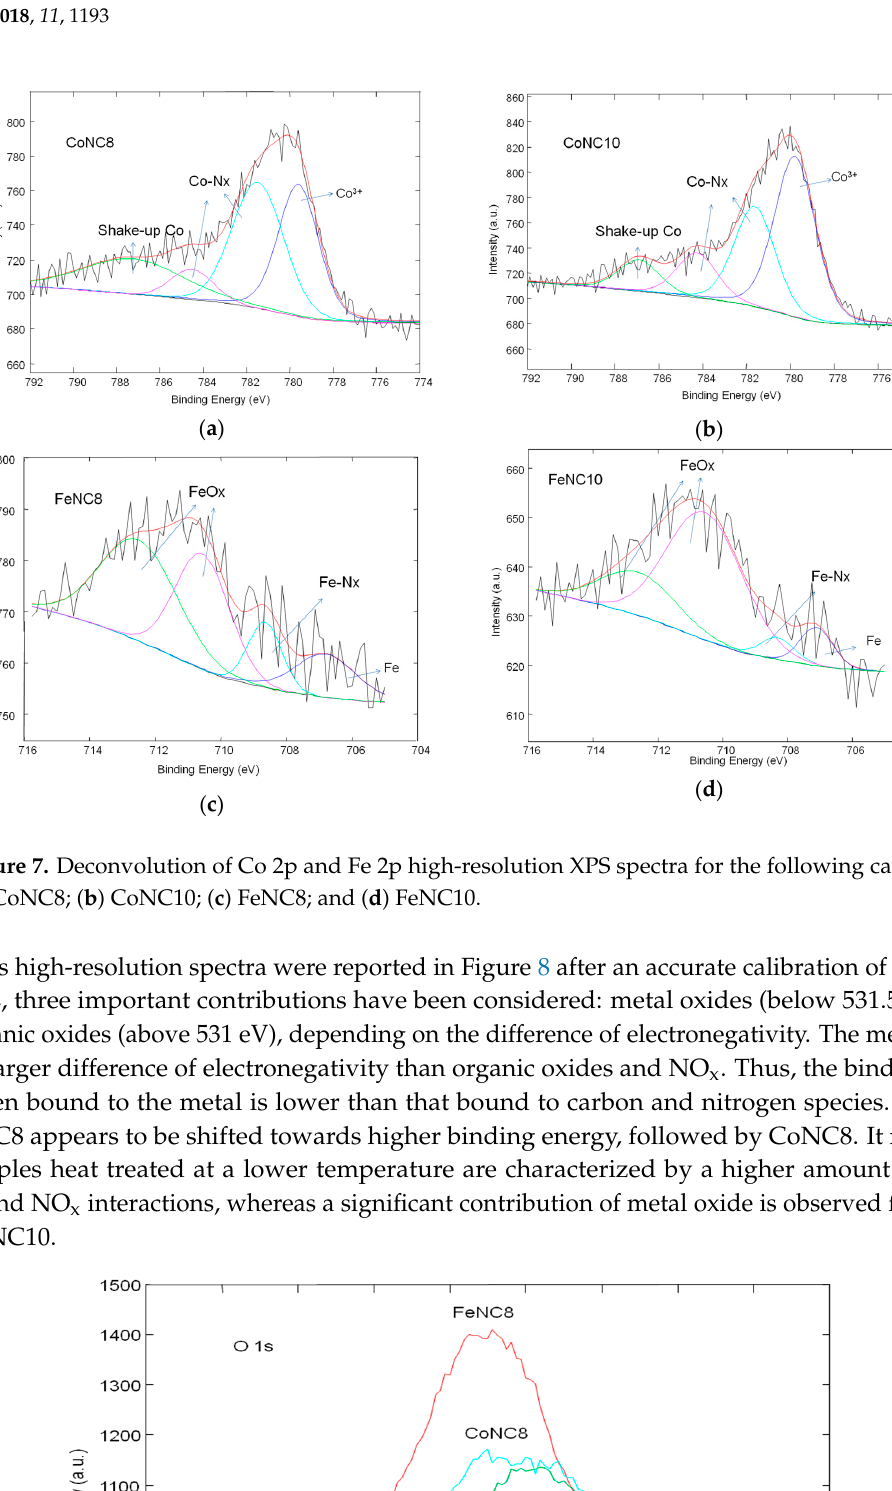
Figure 8. O 1s high resolution XPS spectra for CoNC8, CoNC10, FeNC8, and FeNC10 catalysts.